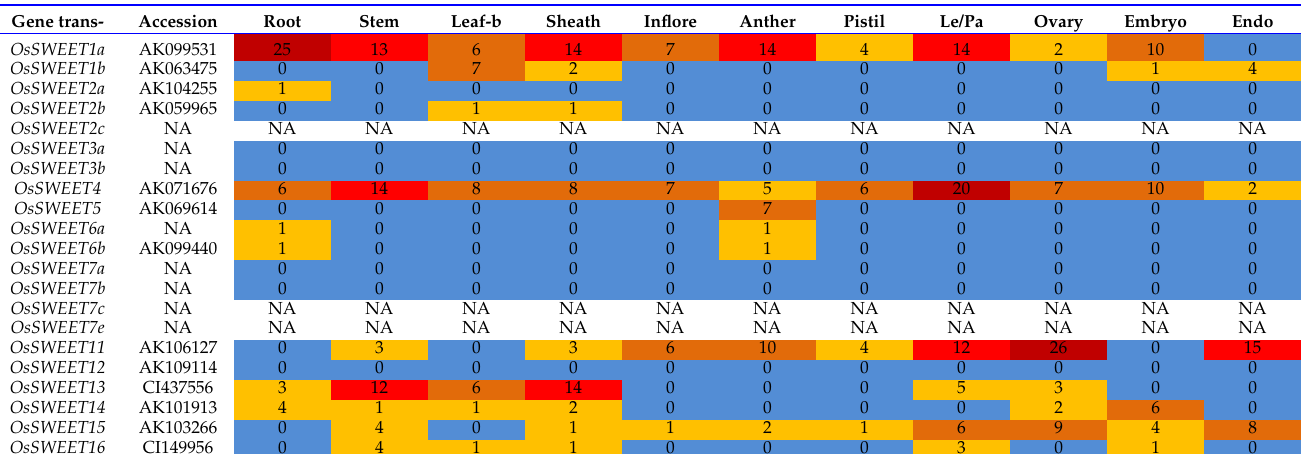
Table 4. Expression levels of SWEET genes in various rice tissues based on gene chip data (https://ricexpro.dna.affrc.go.jp/, accessed on 22 August 2021).